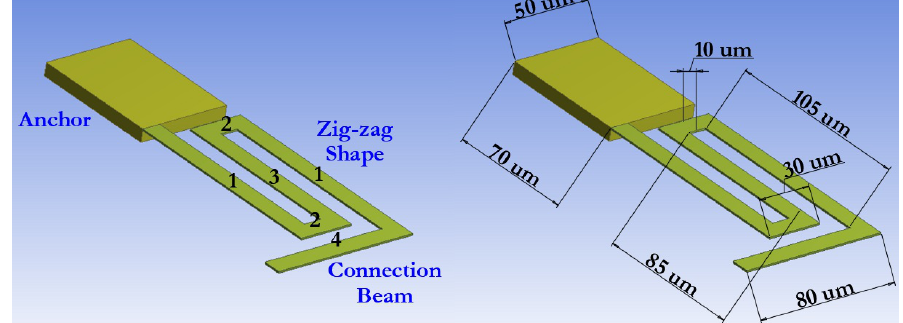
Figure 16. Schematic view of the developed zig-zag elastic suspension. The effective stiffness coefficient of the presented zig-zag elastic suspension is deter- mined using Equation